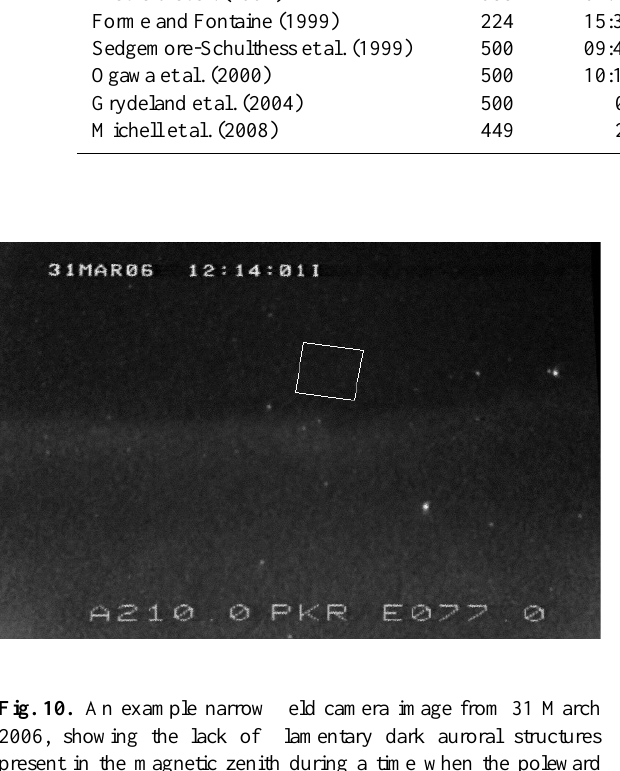
Fig. 11. An example all-sky camera image from 31 March 2006, showing the auroral context, and the poleward edge of the aurora near the magnetic zenith at the time of the image shown in Fig. 10. The black spot near the center marks the location of the radar beam. North is down and east is to the